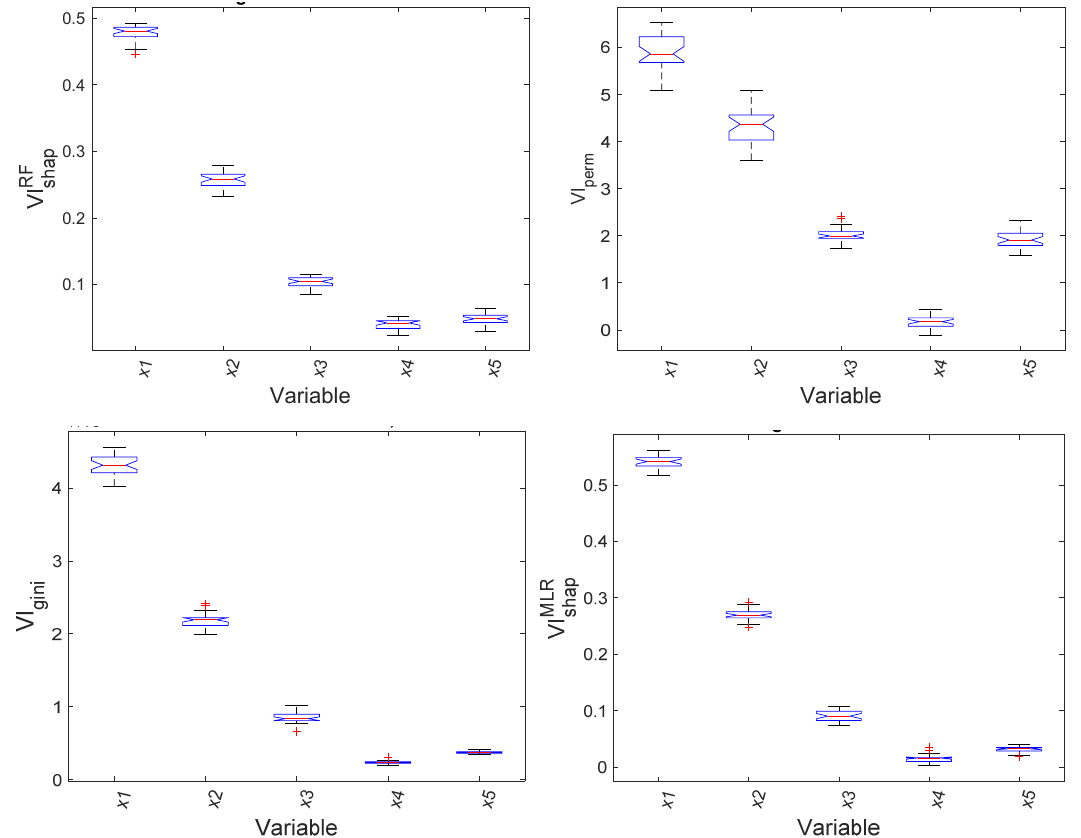
Figure 4. Relative importance of predictors in Case Study 1, based on 100 iterations, showing Shapley values ( top , left ), permutation indices ( top , right ), Gini indices ( bottom , left ), and Shapley values for a multiple linear regression model ( bottom , right ), based on 30 runs.